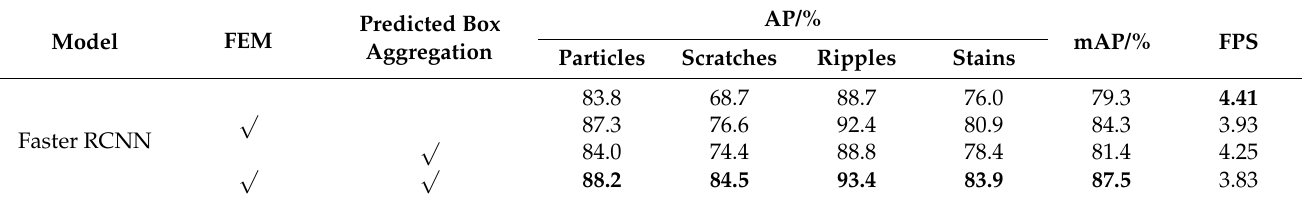
Table 2. Impact of the FEM and predicted box aggregation on the detection results.